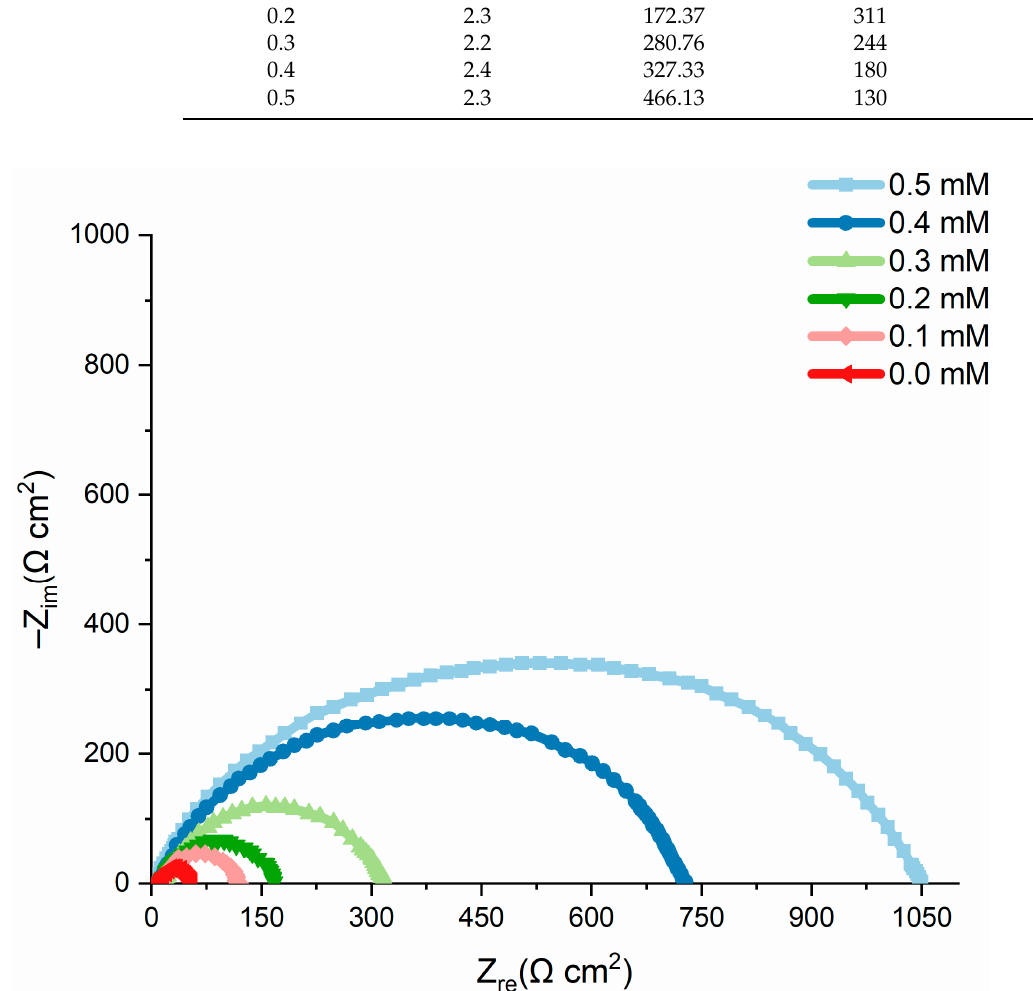
Figure 8. Nyquist plots of the test samples in acidic solution in the absence and presence of different concentrations of nicotinehydrazide derivative at 303 K.